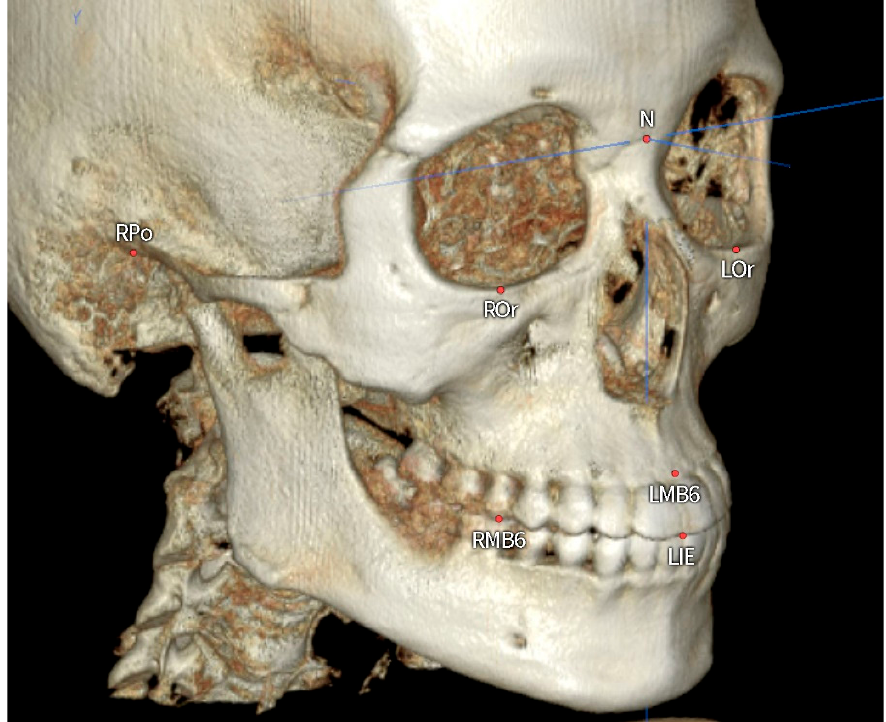
Figure 1. Reference planes and landmarks for reorientation of the CBCT images. Nasion, right and left orbitale and right porion were used for reorientation to generate two-dimensional cephalographs. The mandibular occlusal plane was formed by the lower incisor edge (LIE) and right and left mesiobuccal cusps of the mandibular first molars (RMB6, LMB6).